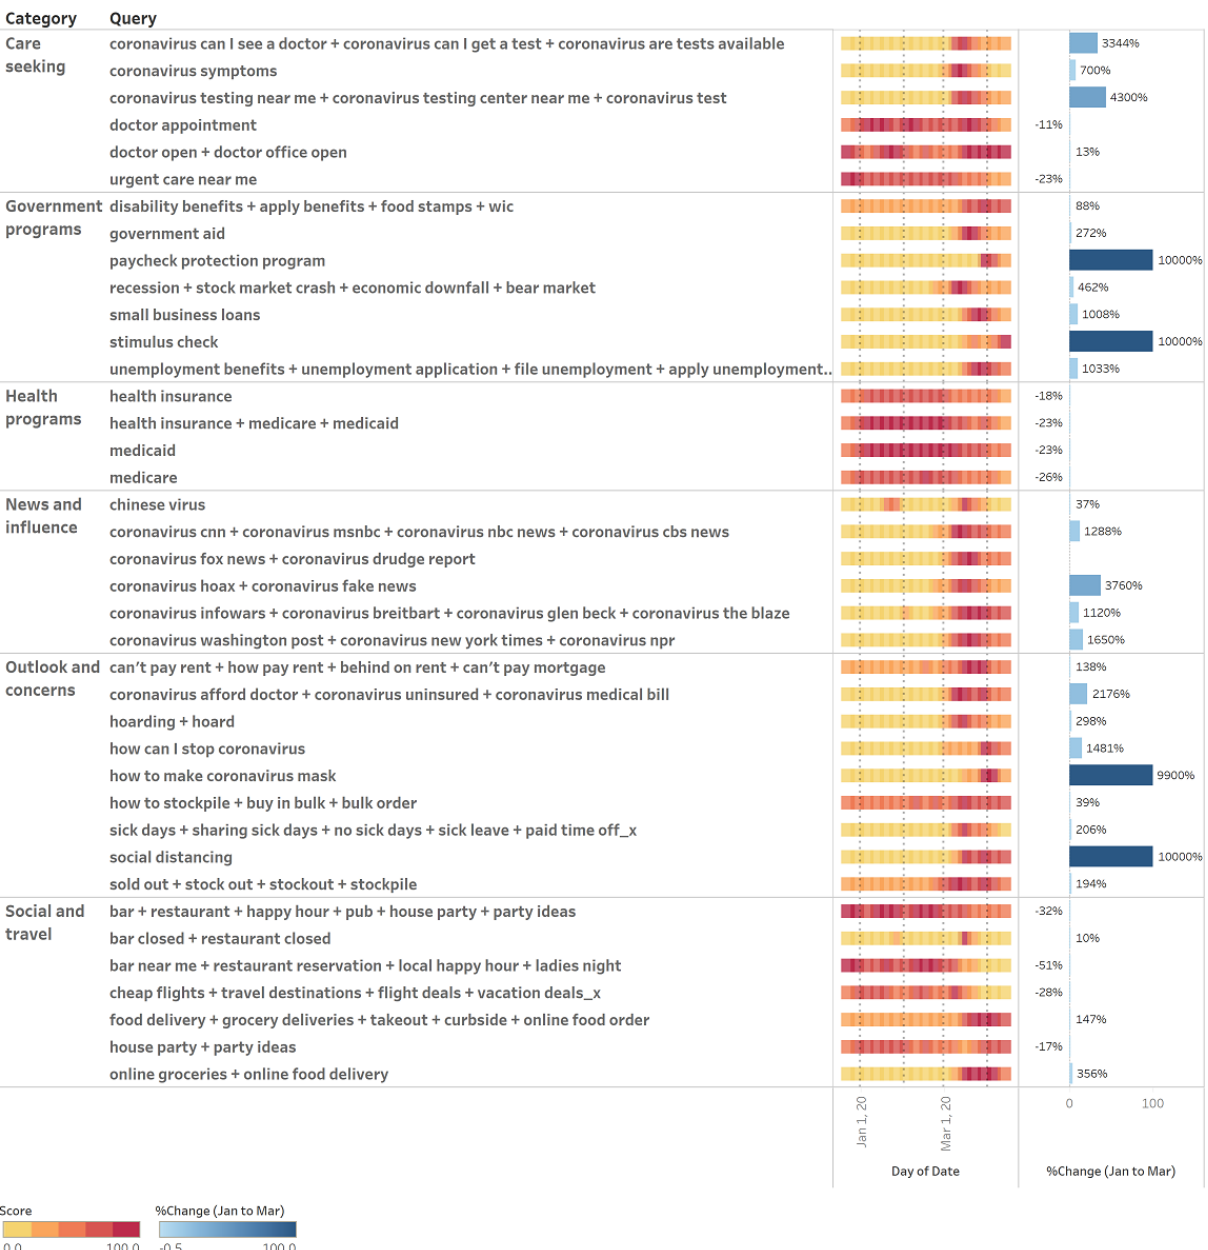
Figure 1. National search pattern for each query in every theme by relative search value for 16 weeks between January 1 and April 15, 2020. The right panel shows the change in monthly average relative search value between January and March, capped at 10,000% for queries with extremely high